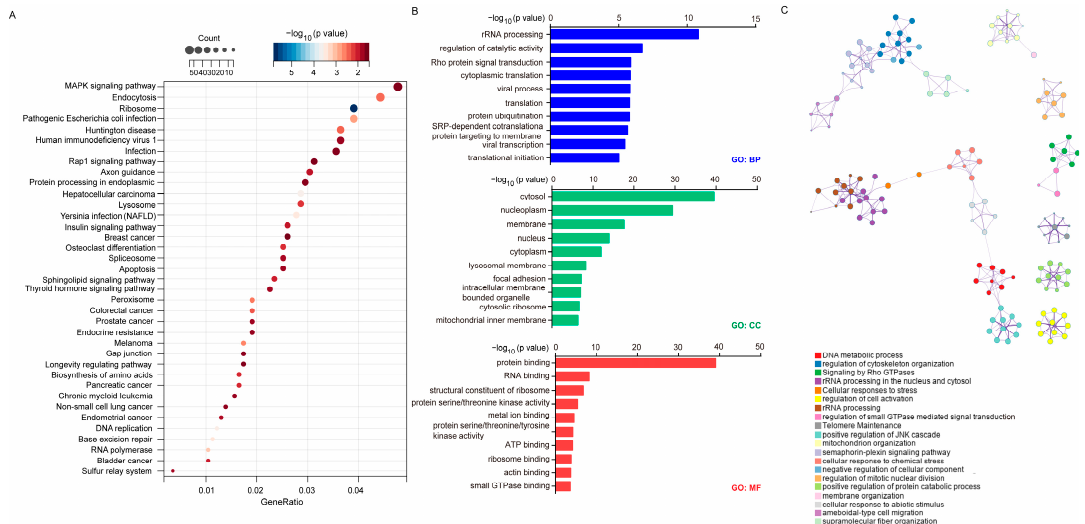
Figure 8. Enrichment analysis of genes regulated by FBXW9 in breast cancer. ( A ) KEGG analysis of the differentially expressed genes. ( B ) GO analysis of the differentially expressed genes. ( C ) Gene enrichment analysis was performed on the differentially expressed genes using Metascape.